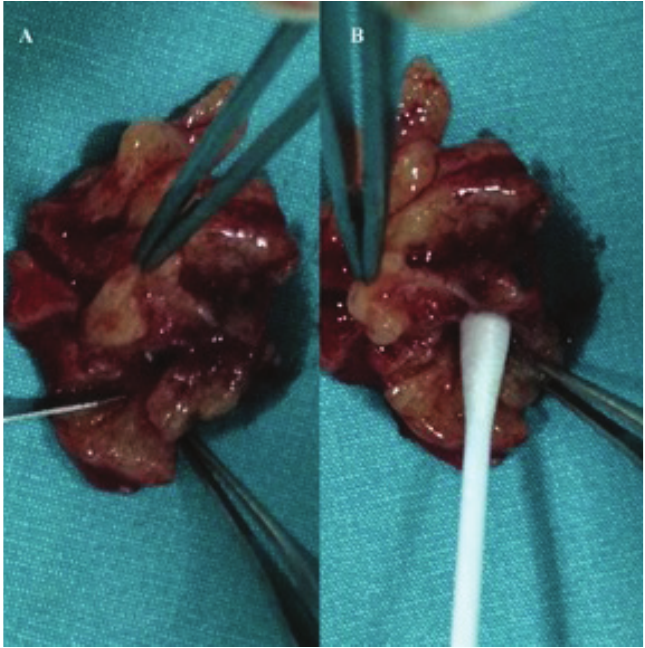
Figure 1. Acquisition of adenoid core culture: exposition of the deep surface of the adenoid with a sterile scalpel (A) and swabbing the core with the applicator